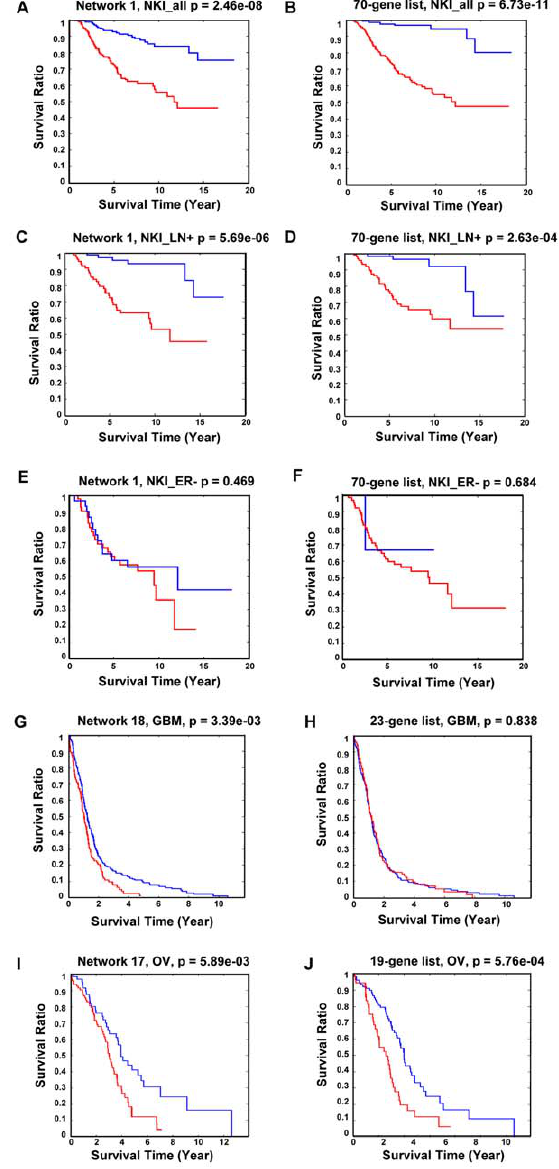
Figure 4. Kaplan-Meier curve of breast cancer, glioblastoma (GBM) and ovarian cancer (OV) using network genes identified from cancer datasets. The p-values are computed using Log- rank test with 100 repeats. A: using Network 1 genes on NKI mixed cohort; B: using Van’t Veer 70-gene signature [1] on NKI mixed cohort; C: using Network 1 genes on NKI LN + cohort; D: using van’t Veer 70-gene signature [1] on NKI LN + cohort; E: using Network1 genes on NKI ER 2 cohort; F: using Van’t Veer 70-gene signature on NKI ER 2 data. G: using Network 18 genes on TCGA GBM dataset; H: using 23-gene signature on TCGA GBM cohort [28]. I: using Network 17 genes on TCGA OV cohort. J: using 19-gene signature on TCGA OV dataset [34]. Blue lines: good survival outcome group; Red lines: poor survival outcome group. LN + : lymph node positive. ER 2 : estrogen receptor negative.